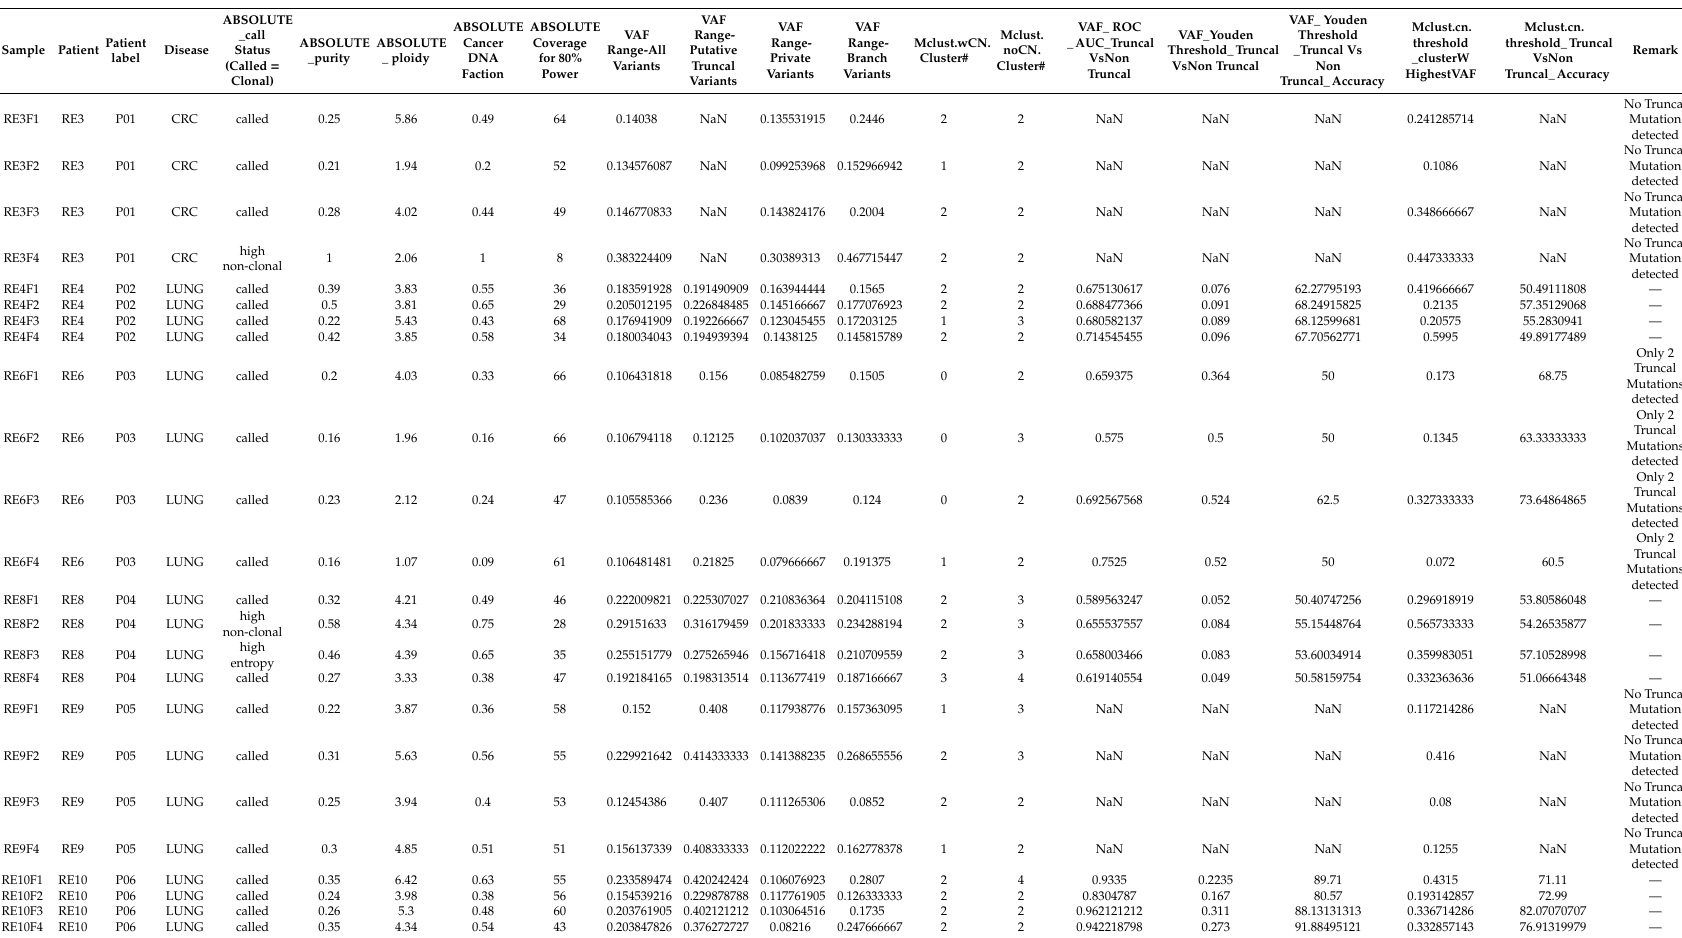
Table A1. Assessment of tumor purity for each sample using ABSOLUTE algorithm. Abbrev: VAF, variant allele frequency; BRCA, breast carcinoma; CRC, colorectal carcinoma; OV, ovarian carcinoma; UCEC, uterine carcinoma; LIHC, hepatocellular carcinoma; NaN, not computable. Sample Patient Patient label